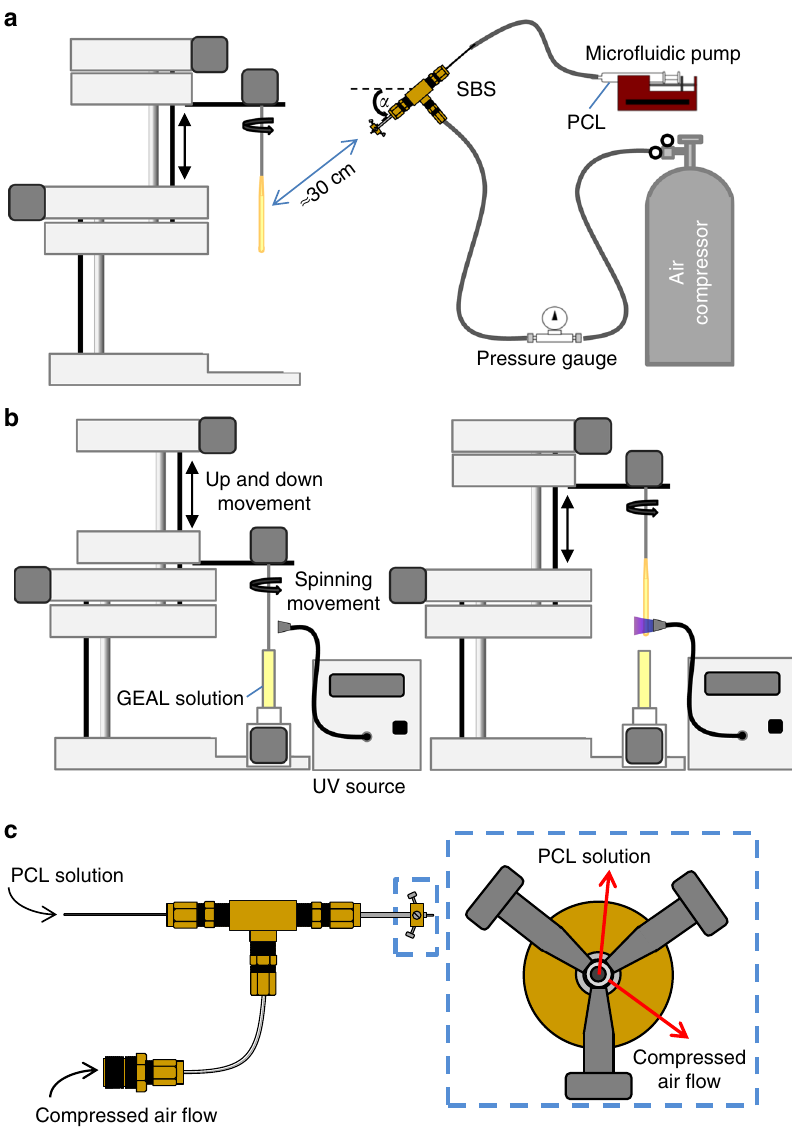
Fig. 2 Fabrication method of small diameter vascular graft (SDVG) through the deposition of methacryloyl gelatin-alginate (GEAL) and poly( ε - caprolactone) (PCL) fi bres sublayers. a Fabrication of PCL fi bre sublayer by deposition of PCL fi bres into a spinning rod via angled solution blow spinning. During this process the rod moves vertically via the dip-spinning system. b Fabrication of GEAL sublayers by vertical dipping of an orientated fi bre-coated rod into GEAL solution followed by rotational retraction and exposure to ultraviolet (UV) light. c Solution blow-spinning (SBS) apparatus showing a central- inner nozzle for the extrusion of PCL solution, and a concentric-outer nozzle for delivery of compressed air (right, end view). The central-inner